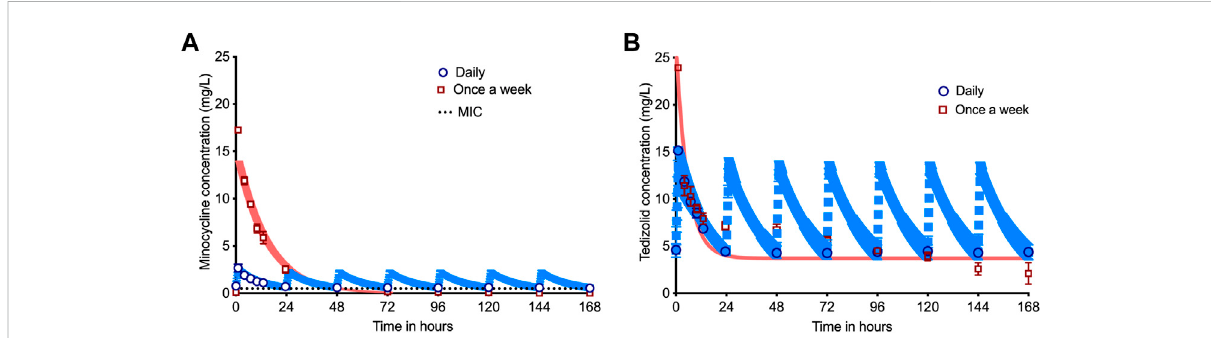
FIGURE 1 Pharmacokinetics of minocycline and tedizolid in dual therapy. The symbols are mean concentrations, error bars are standard deviation, and shaded areas are pharmacokinetic (PK) model predicted concentrations. The blue line is PK-model predicted for daily therapy, while the salmon colored line is PK-model predicted for once a week therapy. (A) Concentration-time pro fi le for the once-a-week minocycline doses compared to daily doses demonstrated that minocycline concentration declined below the MIC by 48 h (28.57% of the once-a-week dosing interval)for the once-a-week dosing schedulebut stayedabove theMIC for 100%of168 hwith dailydose. (B) Concentration-timepro fi lefor thecompaniononce- a-week tedizolid doses versus daily dose demonstrates that the tedizolid peak concentration could not reach 7 times that of the daily dose due to solubility issues, which means that the once-a-week regimen was prejudiced comparedto daily therapy since the daily therapy schedule achieved a 49.6% higher cumulative AUC per week than once-a-week regimen.